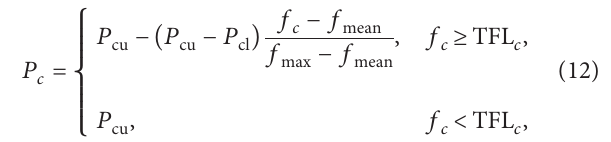
1 ( t ), f 2 ( t ), and f 3 ( t )